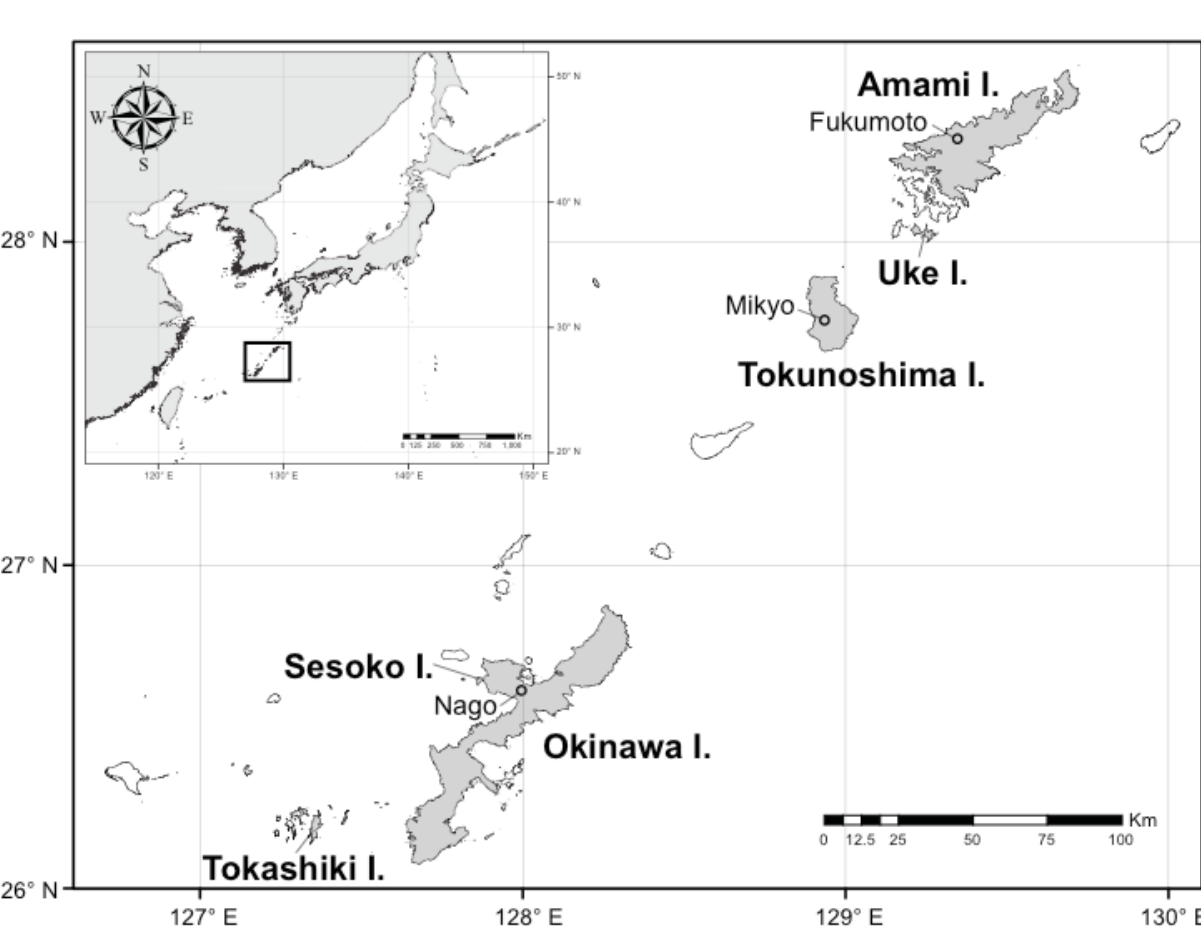
Figure 1. Map showing the distribution of Echinotriton andersoni in the Ryukyu Islands, and the collection